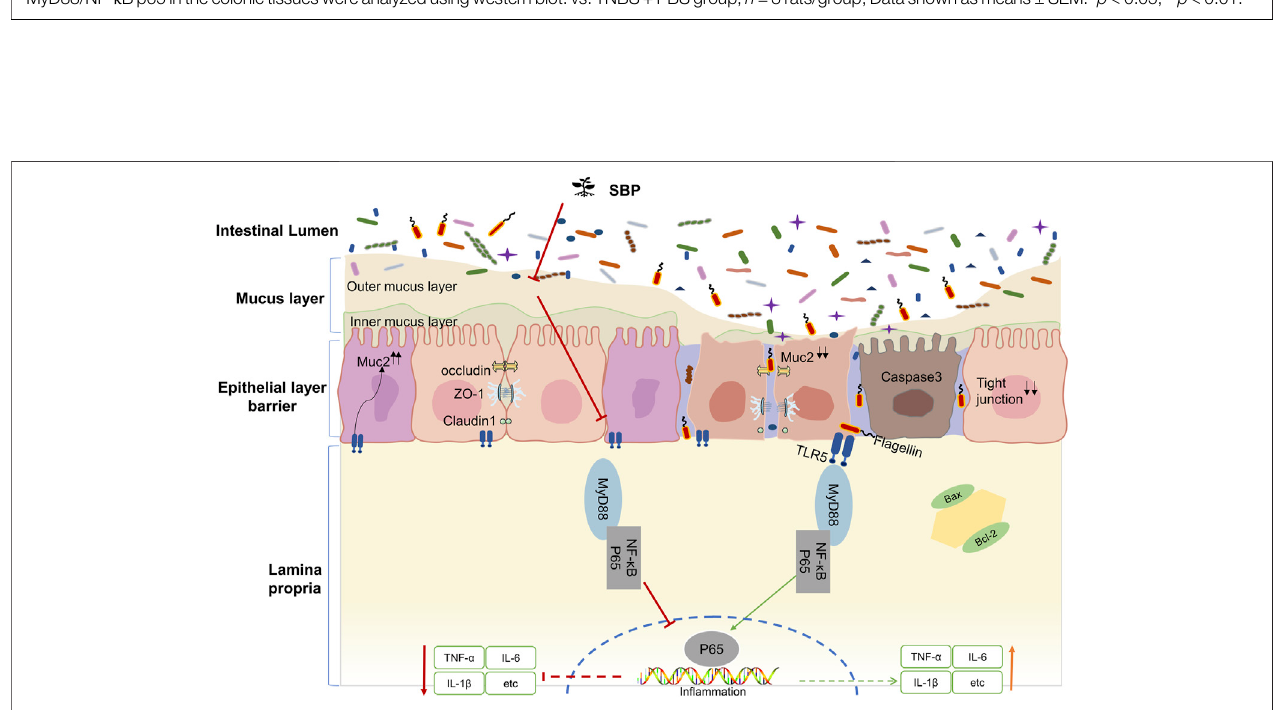
FIGURE 8 | Proposed mechanism involving the TLR5/MyD88/NF- κ B pathway.